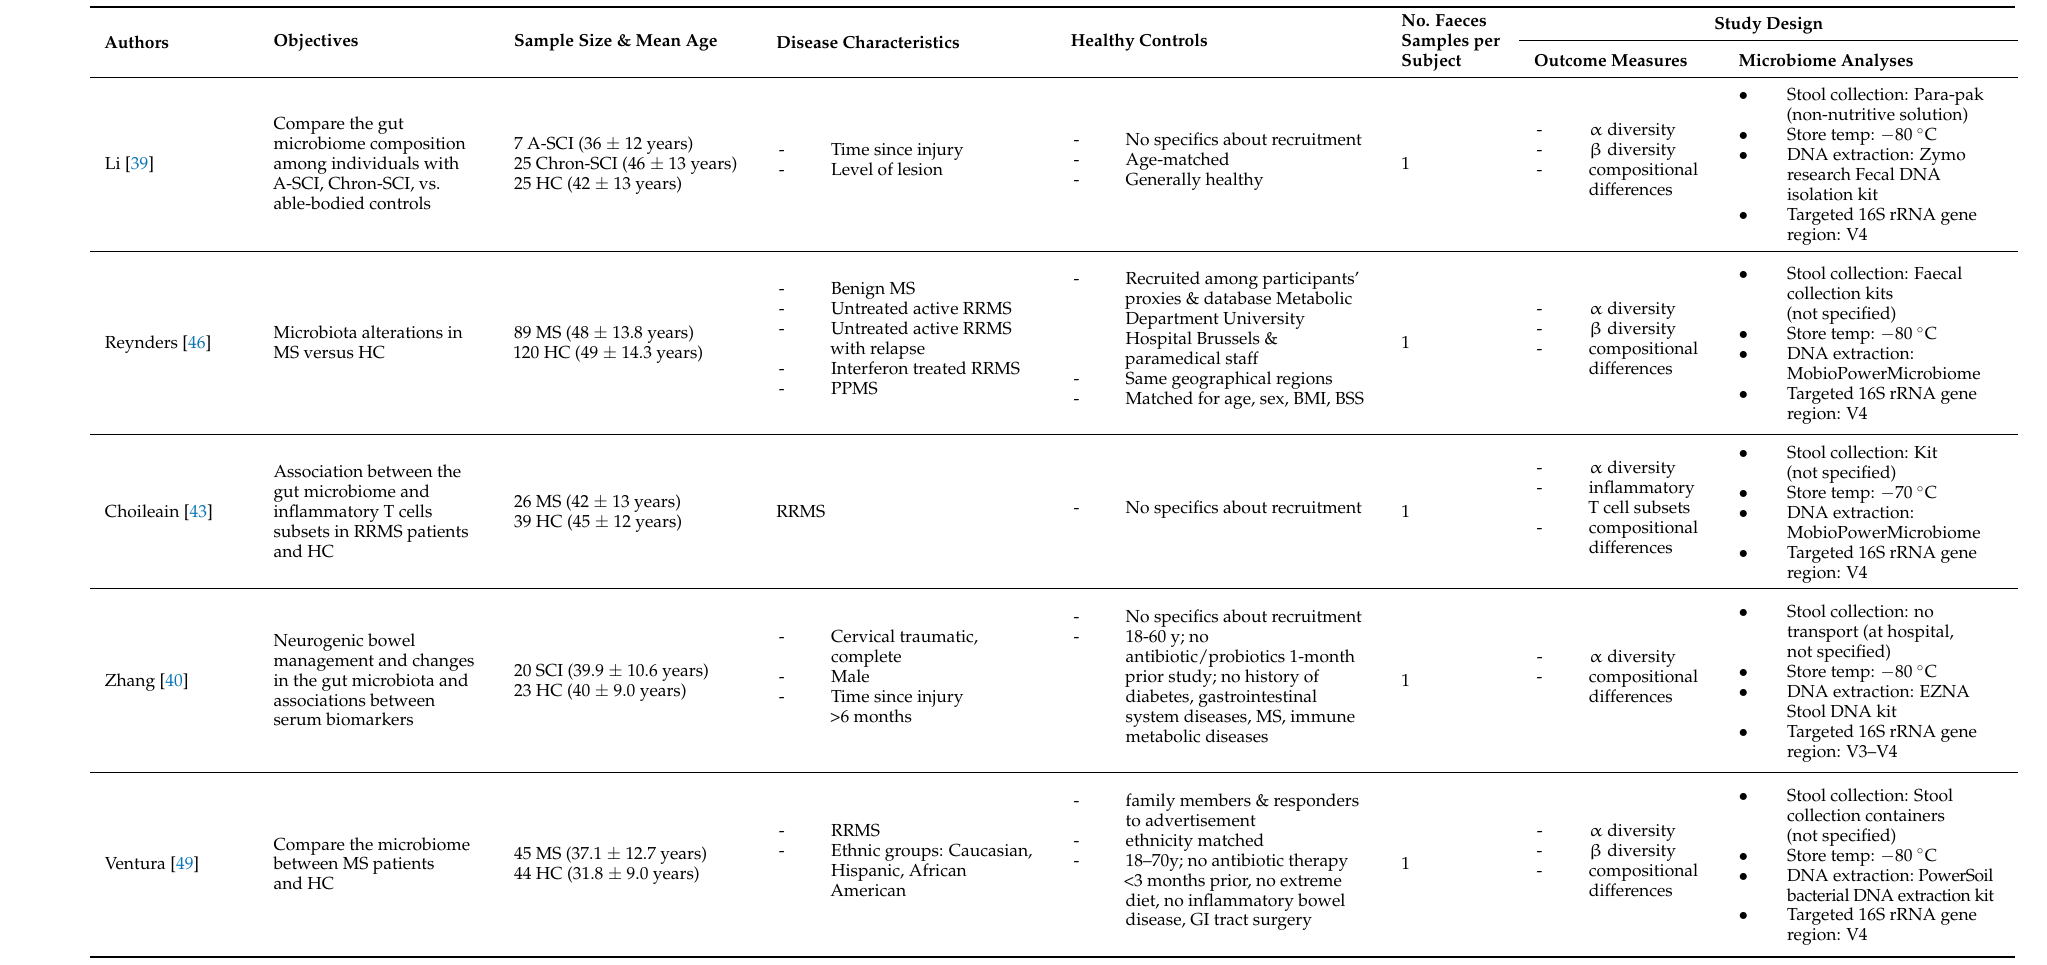
Table 1. Description of the included articles arranged by